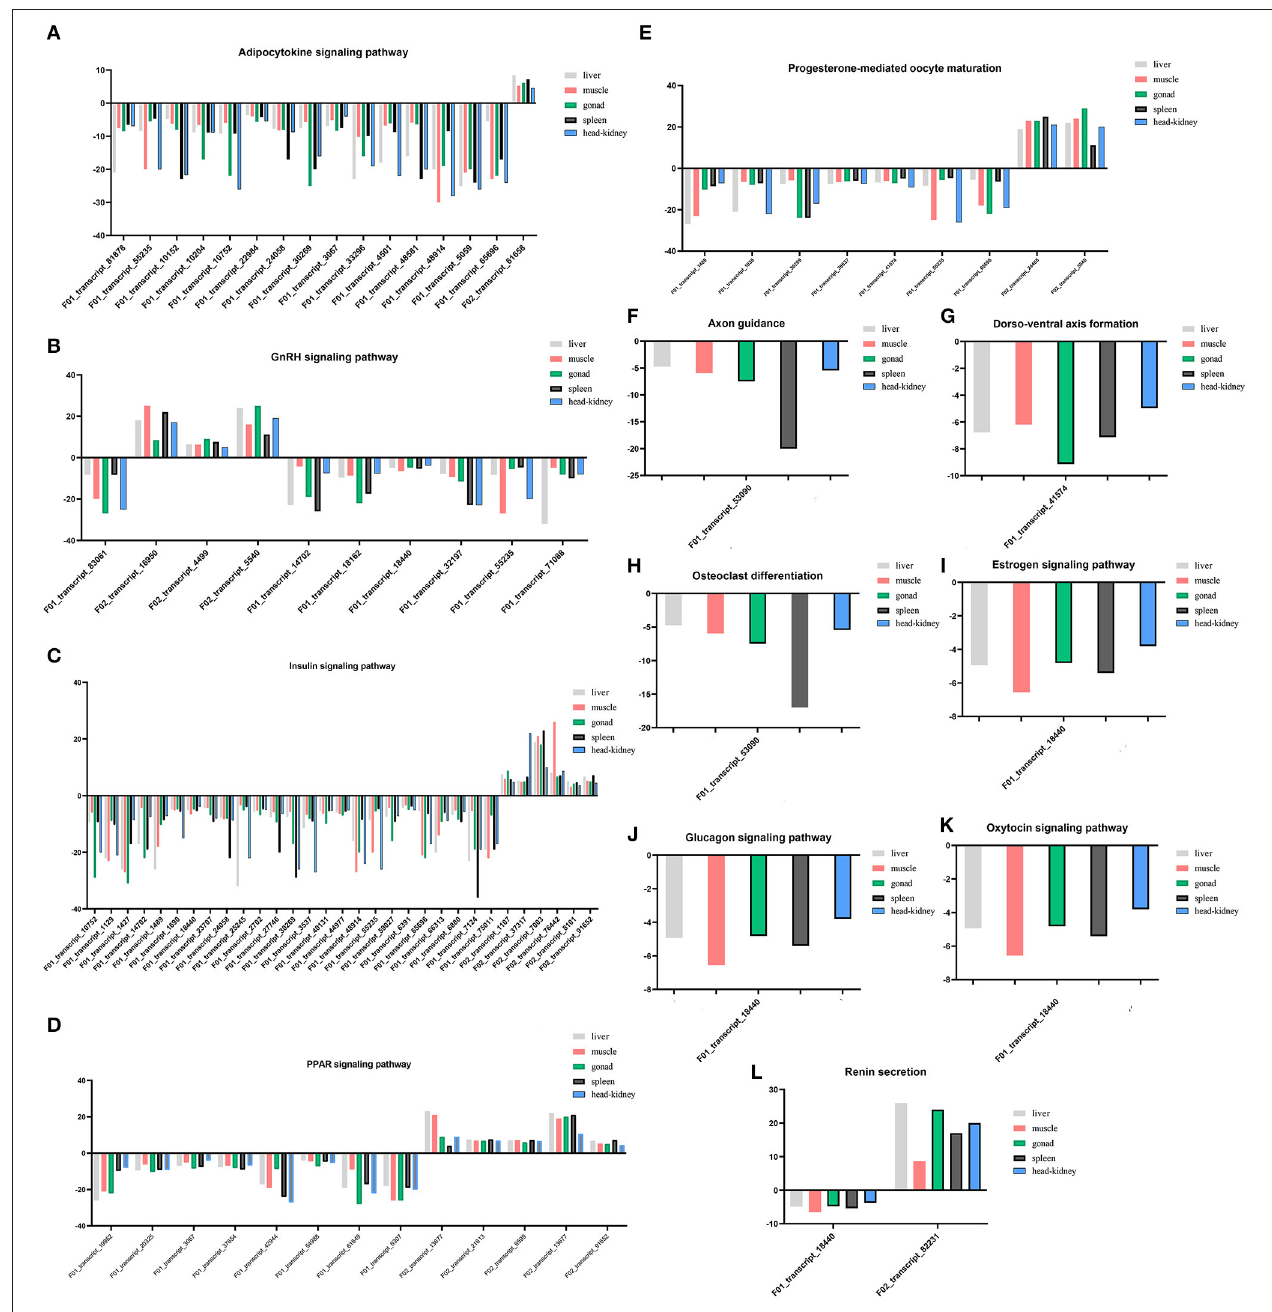
FIGURE 4 | (A–L) Expression profiles of DEGs enriched in pathways involved in endocrine system and development in five